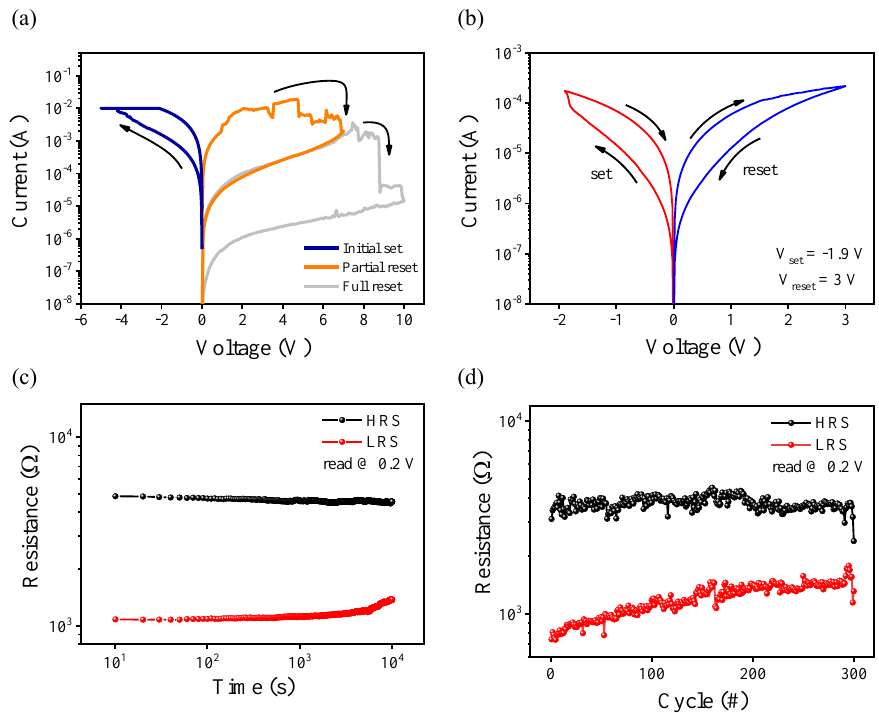
Figure 3. Electrical characteristics of ITO/WO X /ITO device. ( a ) First voltage sweep determining the type of I – V curve according to the reset process. ( b ) Gradual analog switching achieved from the partial reset. ( c ) Retention, read at the voltage of 0.2 V at room temperature for over 10 4 s. ( d ) Endurance characteristics evaluated through DC voltage cycles.